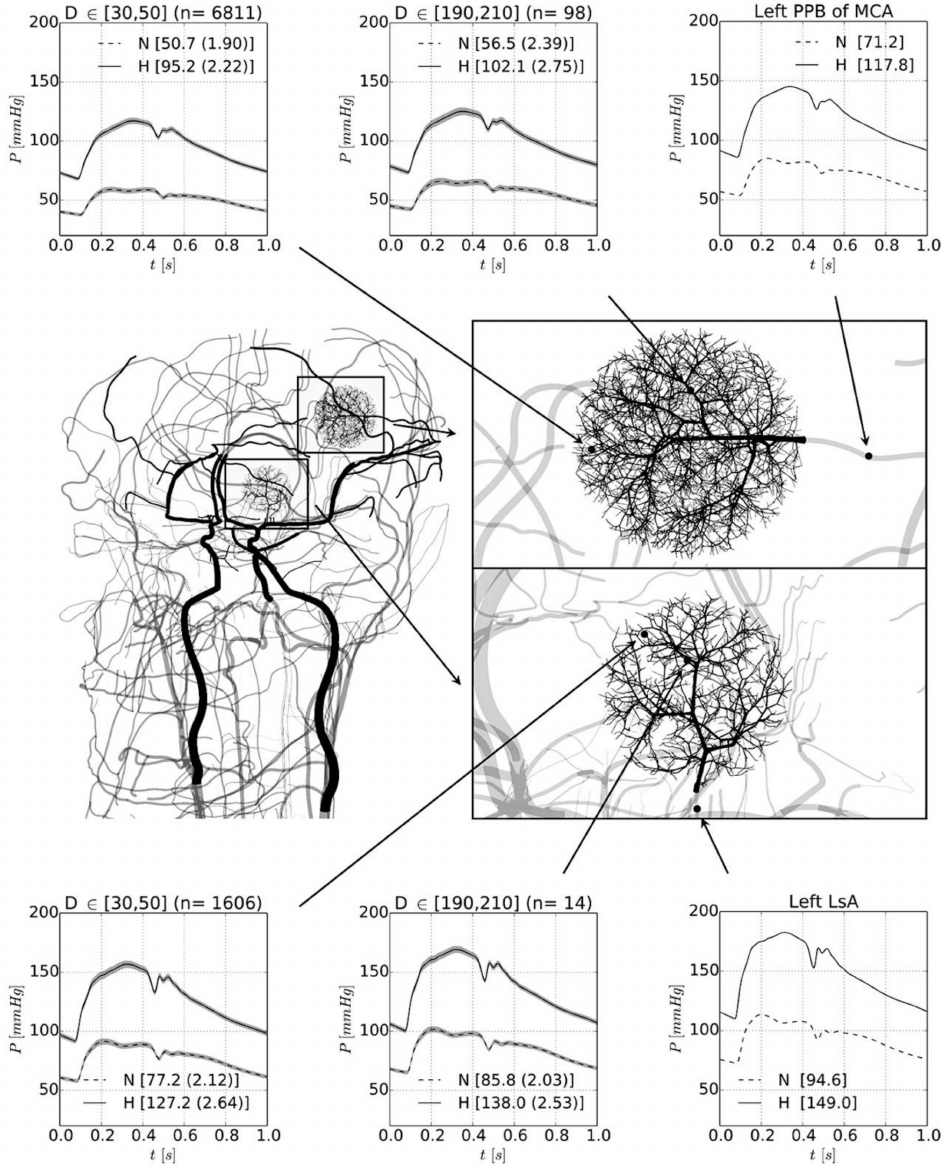
Figure 2. Blood pressure gradients in the brain. Detail of the peripheral beds corresponding to the lenticulostriate artery and to the posterior parietal branch of the middle cerebral artery. Pressure waveforms are shown for the normotensive (N, dashed line) and hypertensive (H, solid line) cases. Right panels (top and bottom) display the pressure waveform in the feeding artery to the corresponding arteriolar networks. Middle and left panels show the pressure level in arterioles with diameter ranges between D ∈ [190 µ m, 210 µ m] and D ∈ [30 µ m, 50 µ m], respectively; n indicates the number of vessels taken to calculate the average and SD pressure waveforms (grey-shaded area). In brackets, the mean arterial pressure is reported. LsA, lenticulostriate artery; MCA, middle cerebral artery; PPB, posterior parietal branch. (Reproduced by permission of BMJ from Blanco, P.; Mueller, L.; Spence, J.D. Blood pressure gradients in cerebral arteries: A clue to pathogenesis of cerebral small vessel disease. Stroke Vasc. Neurol . 2017 , 2 , 108–117)